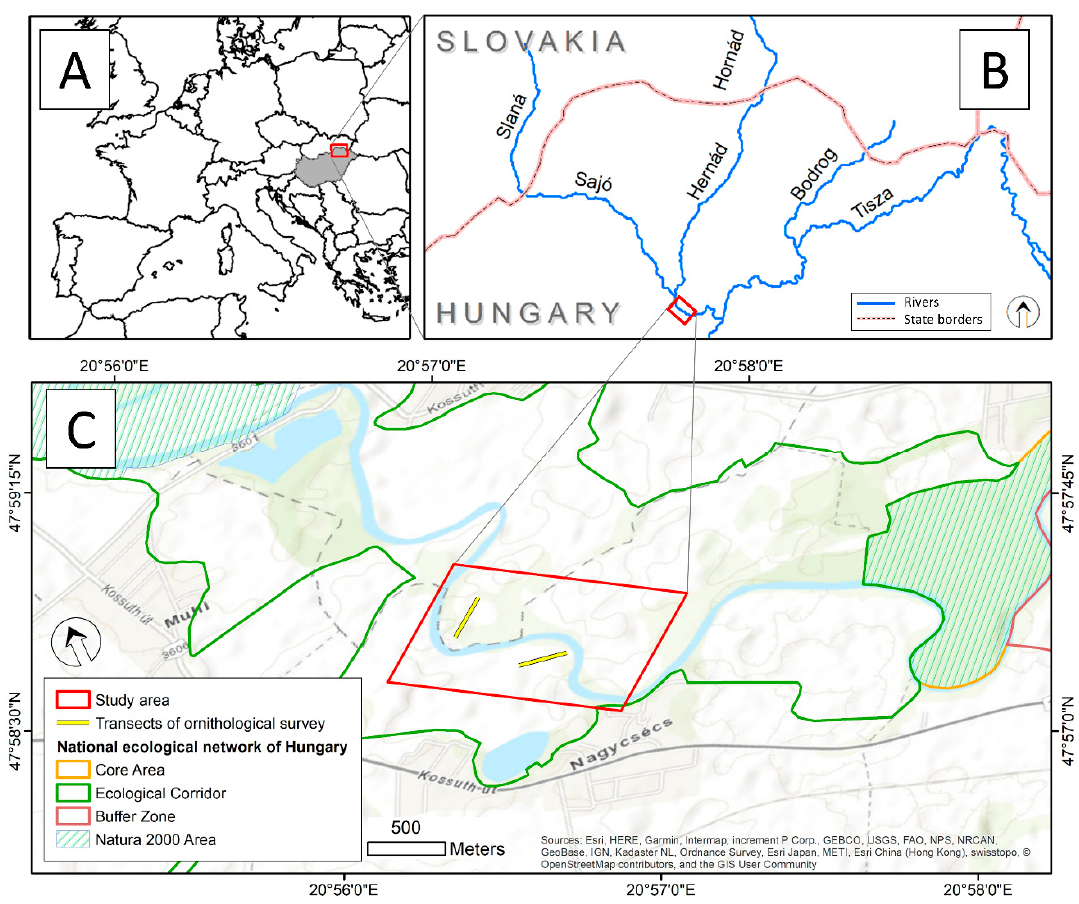
Figure 1. Overview of the study area. ( A ) Location of the study area in Europe; ( B ) Location of the main rivers in the region of study area; ( C ) Detailed overview of the selected sub-reach of Sajó River.